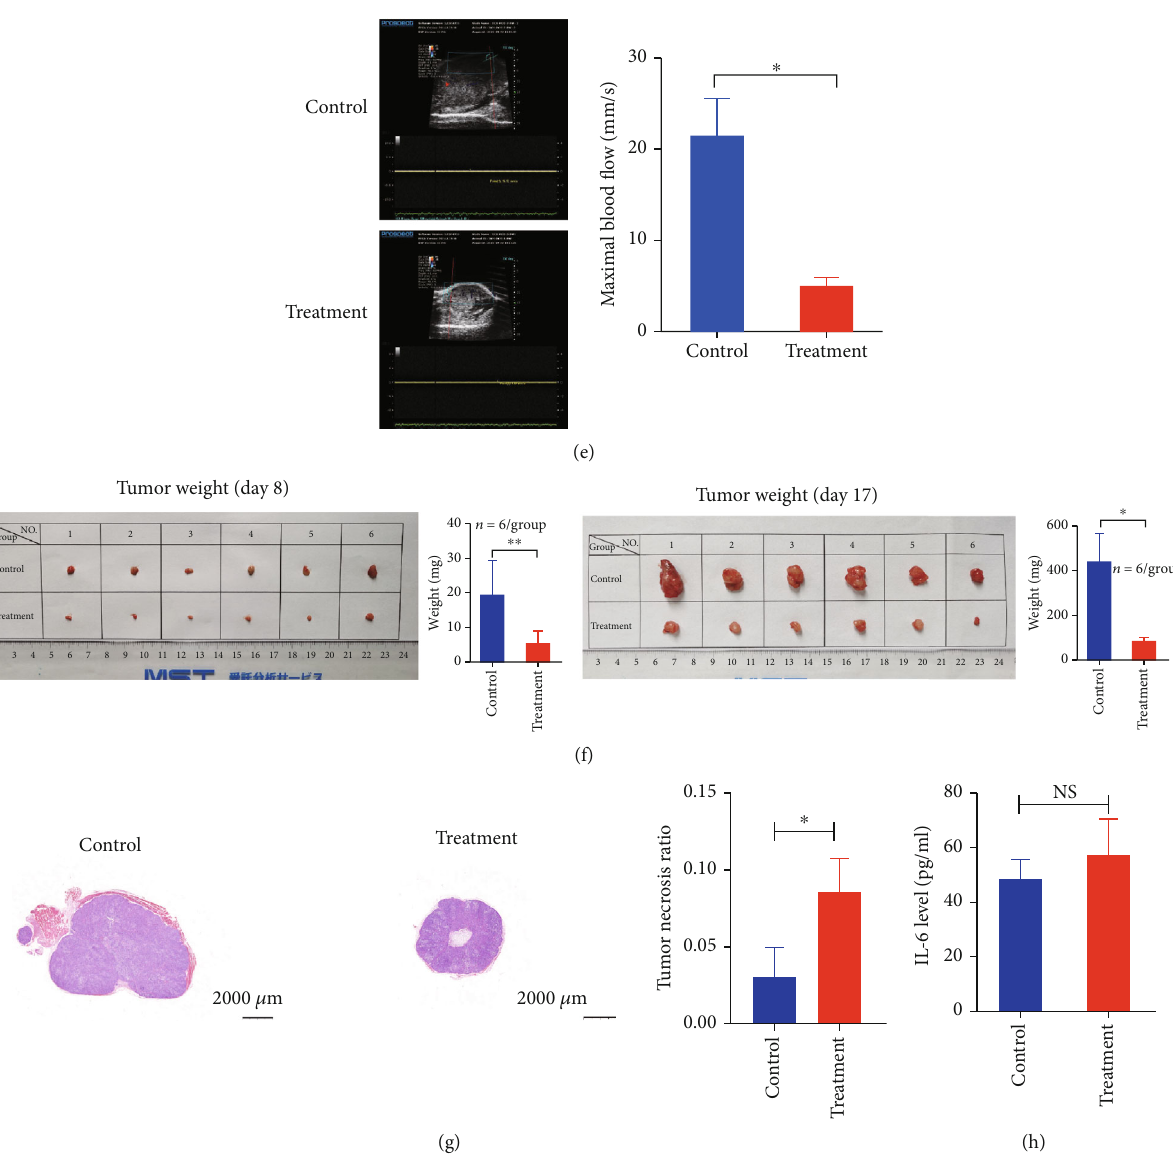
Figure 3: The measurement data of implanted tumors and IL-6 levels in the NK cell treatment and control groups in vivo . (a) Tumor size measured by a caliper in the treatment and control groups over the whole course of treatment ( n = 6 for each group). (b) Body weight in the treatment and control groups over the whole course of treatment ( n = 6 for each group). (c) The CT scan of each mouse after the fi rst and the second cycles of treatment in NK cells and control groups; the tumors were labelled with orange circles in three-dimensional reconstruction image and with blue circles in the cross-section. (d) Tumor size measured by ultrasonography examination in the treatment and control groups before treatment (day 3), after the fi rst (day 7) and the second cycles (day 15) of treatment ( n = 6 for each group). (e) The maximal blood fl ow measured by colored doppler- fl ow mode of ultrasonography in the treatment and control groups on day 15. (f) Images and weight data of harvested tumors from the mice in the treatment and control groups on days 8 and 17 ( n = 6 for each group). (g) HE examination and necrosis area percentages of tumor specimen in the treatment and control groups on day 17 ( n = 6 for each group). (h) Serum IL-6 levels in the treatment and control groups on day 12. Statistical signi fi cance was determined by unpaired t -test. Values are expressed as the means ± SD , ∗ p < 0 : 05 , ∗∗ p < 0 : 01 , and ∗∗∗ p < 0 : 001 ; NS: not signi fi cant; IL-6: